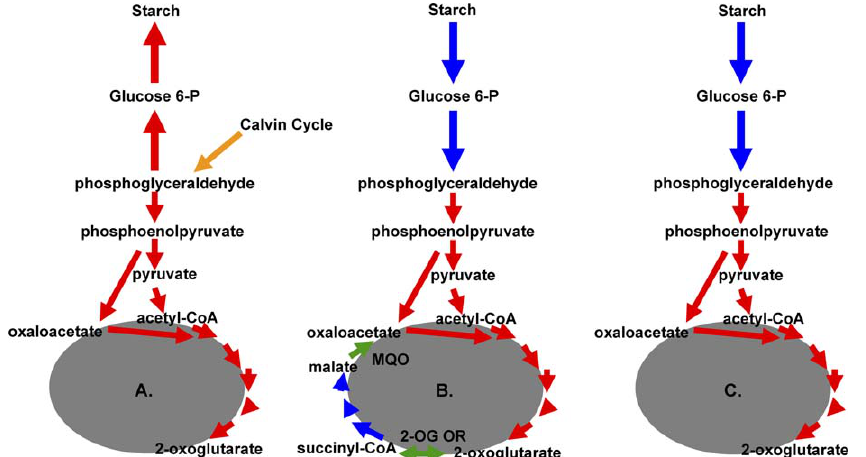
Figure 7. Models for Glycolysis, Gluconeogenesis, and the CAC in Thiom. crunogena XCL-2 Models for central carbon metabolism for cells under environmental conditions with (A) sufficient reduced sulfur and oxygen; (B) sulfide scarcity; and (C) oxygen scarcity; green arrows represent the two ‘‘ non-canonical ’’ CAC enzymes, 2-oxoglutarate oxidoreductase (2-OG OR) and malate: quinone oxidoreductase (MQO). DOI: